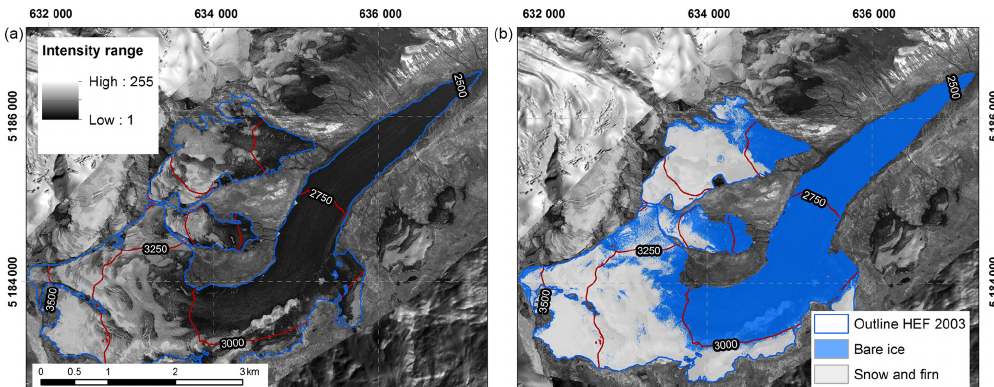
Figure 3. Intensity of the reflected laser beam of the ALS acquisition in 2008 (a) and derived surface classes (b) . The classes are perennial firn with an average density of 700 ± 50kgm − 3 and bare glacier ice of 900 ± 17kgm − 3 . Map coordinates are in